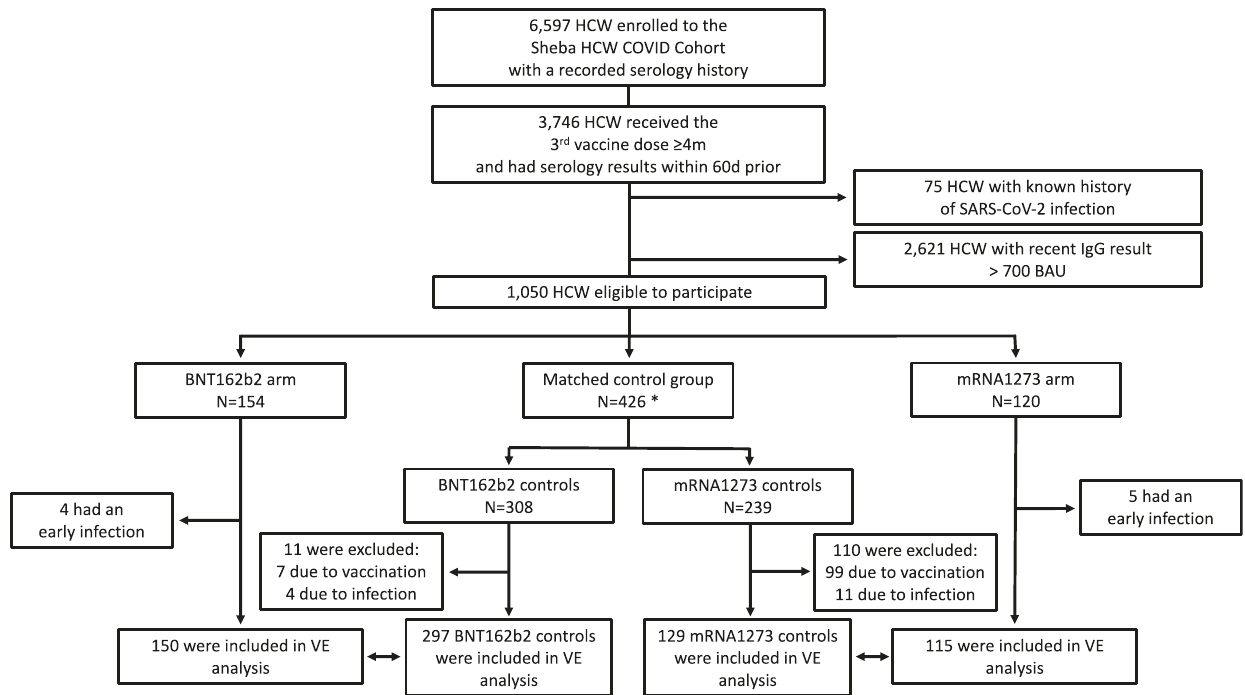
Fig. 1 | Study population fl ow chart. A chart detailing the number of individuals included and excluded according to each eligibility criteria in the study. Partici- pants (vaccine recipients and controls) who experienced early infection (positive SARS-CoV-2 test before day 8) were excluded from the vaccine ef fi cacy analysis.